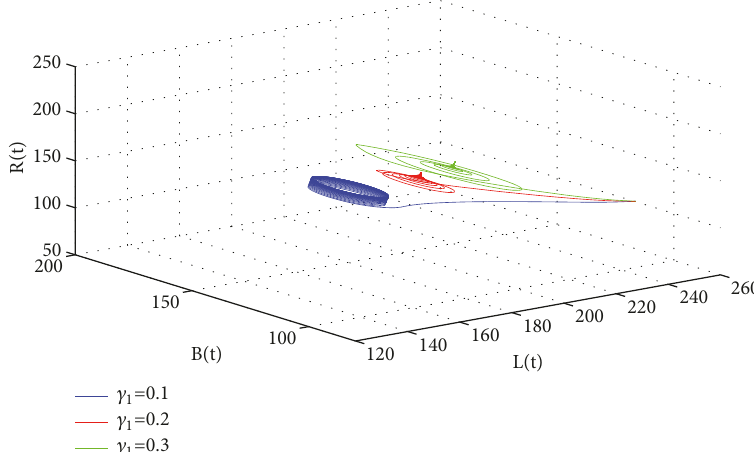
Figure 8: Dynamic behavior of system (61): projection on L-B-R with 𝜏 = 3.6755 > 𝜏 0 = 3.4685 for different 𝛾 1 . Rest of the parameters are taken as given in the text.